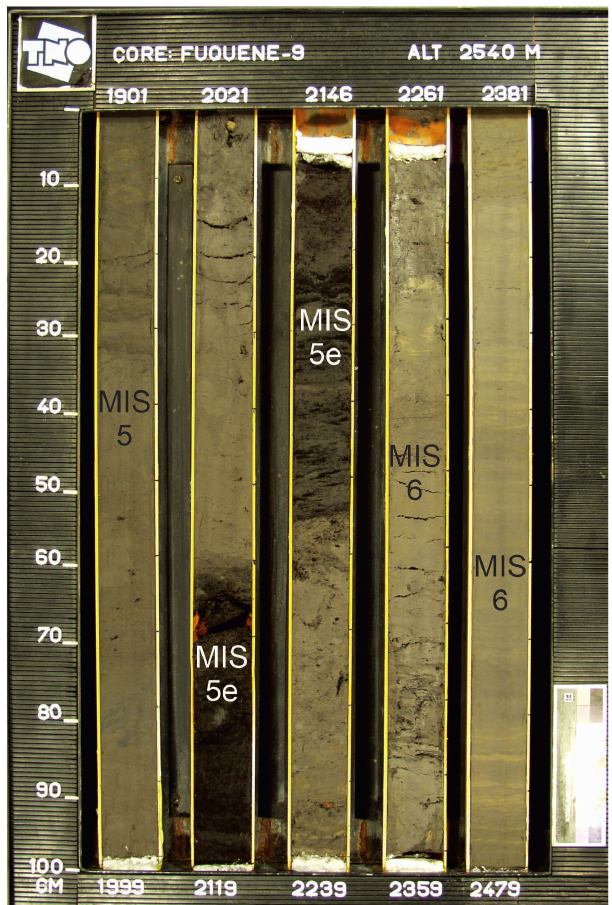
Figure 6. Lithological sequence of the 1901–2479cm interval of core Fúquene 9, reflecting approximately the period from 118 to 135ka. Almost laminated glacial silty clays (2479–2200cm; MIS 6) change into dark organic rich sediments (2190–2090cm), reflecting the compressed peat of the last interglacial (MIS 5e) age and indi- cating that low water tables prevailed. The younger part of MIS 5 was cooler (less evaporation), with higher lake levels explaining the accumulation of silty clays (2080–1900cm). Cores 9 and 10 were lined up using XRF-based geochemical records, as shown in Groot et al. (2011). Composite pollen record of Fúquene 9C mainly con- sists of Fúquene 9 sediments. At intervals where core Fúquene 10 provided a more reliable stratigraphy, small intervals of core 9 were replaced by core 10. Photograph courtesy of TNO Core Laboratory, Utrecht, The